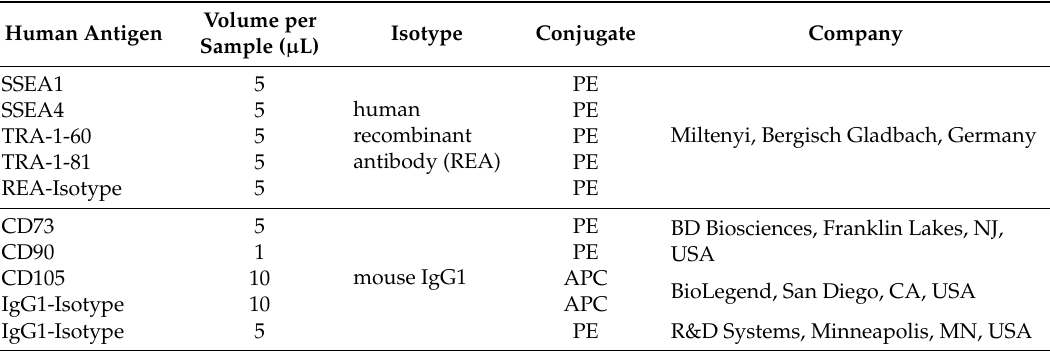
Table 1. List of antibodies used for flow